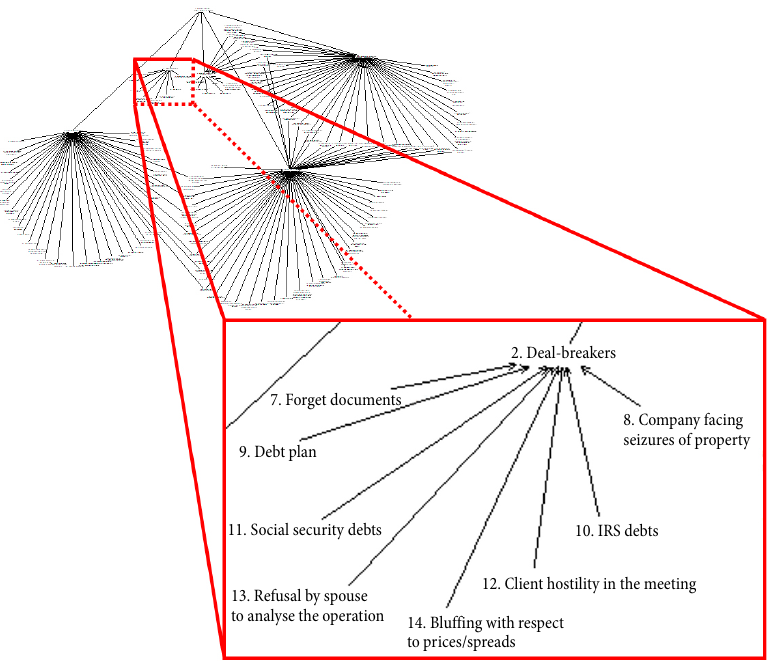
Fig. 2. Final version of the collective/strategic map